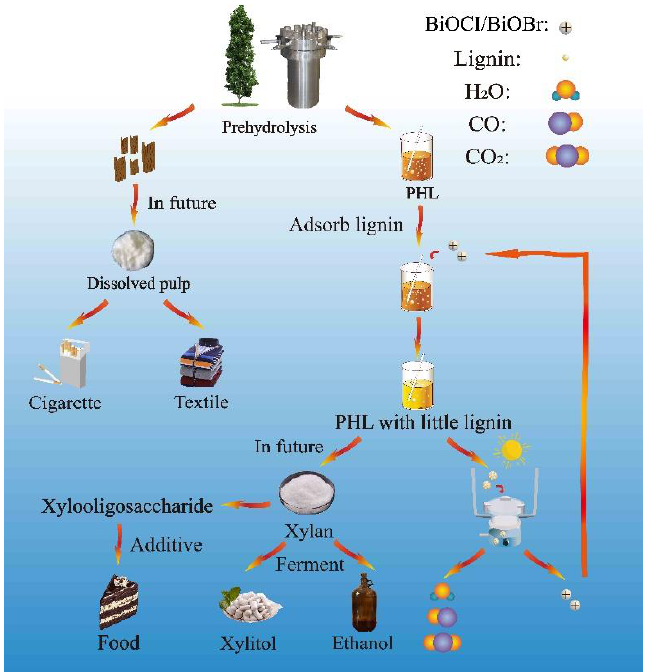
Figure 1. Process diagram for sustainable lignin removal by BiOCl/BiOBr in a kraft-based dissolving pulp production process.